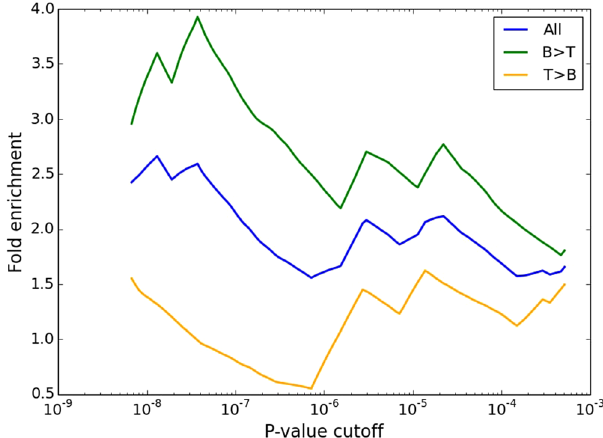
Figure 4. Over-representation of differentially expressed genes. Over-representation of differentially expressed genes between B cells and T cells among the top 40 genes from the random forest prediction of SLE at different significance cutoffs. Blue curve shows all genes; green curve shows genes that were expressed at a higher level in B cells than in T cells; yellow curve shows genes that were expressed at a higher level in T cells than in B cells.